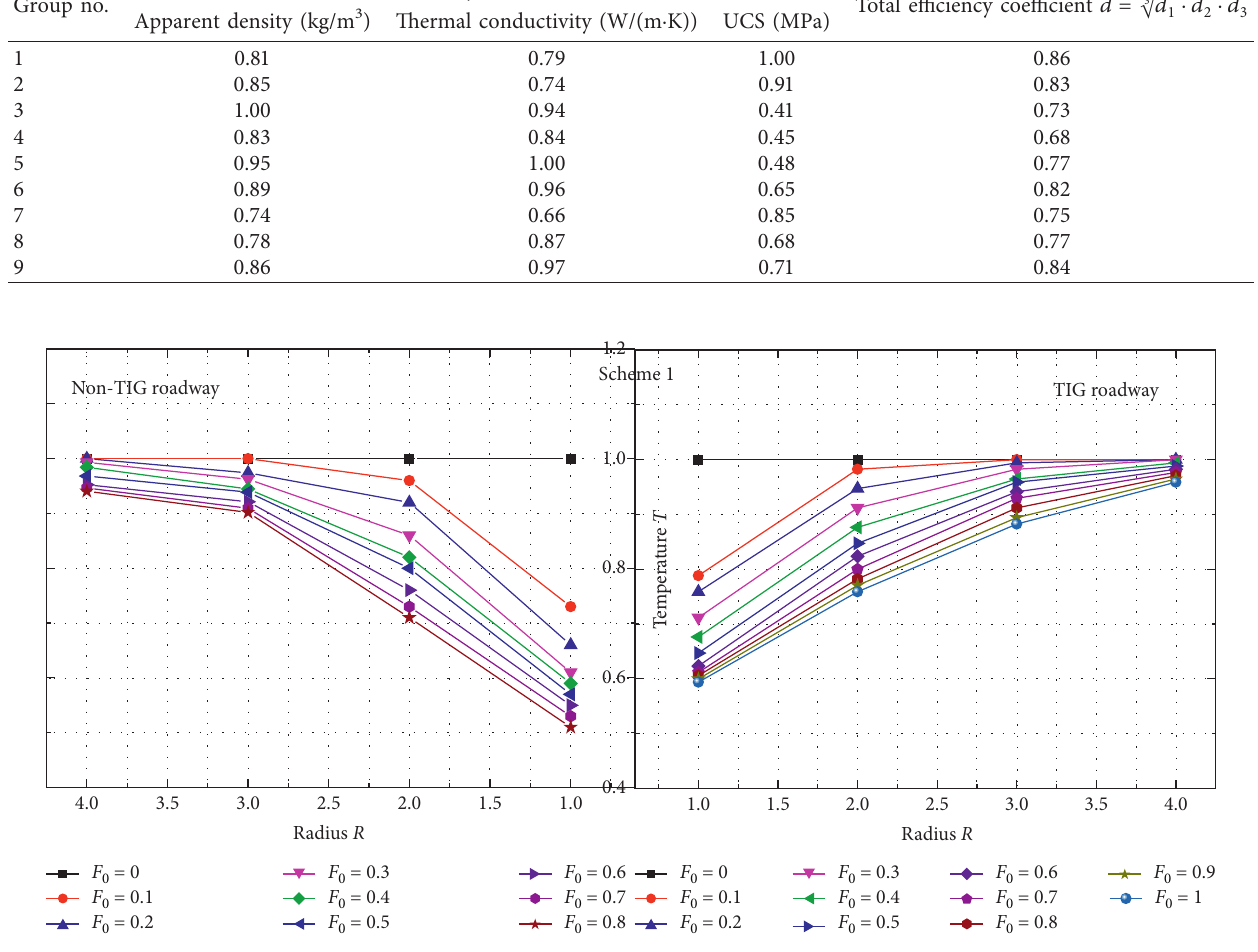
Figure 4: T-R curves of the TIG roadway and non-TIG roadway.